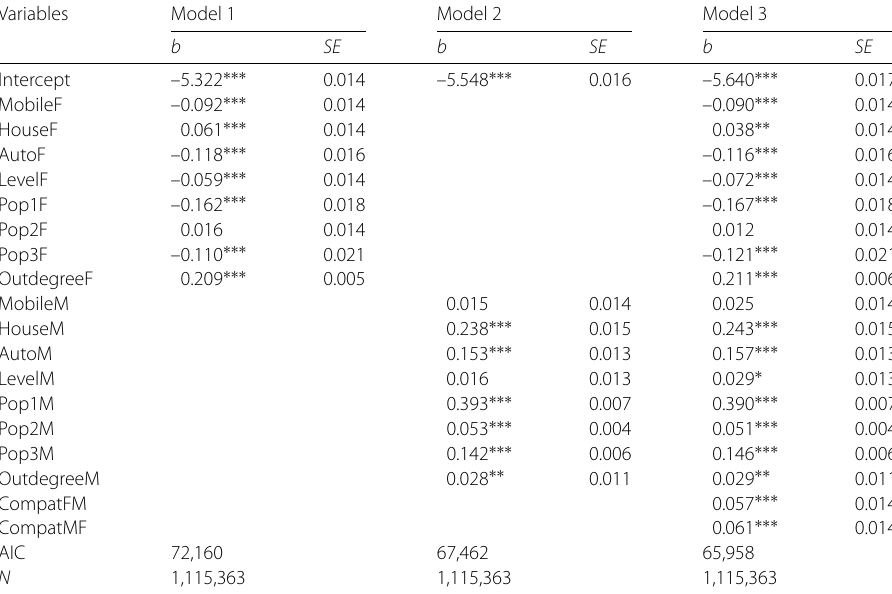
Table 2 Logistic regression results for female users sending messages to male users